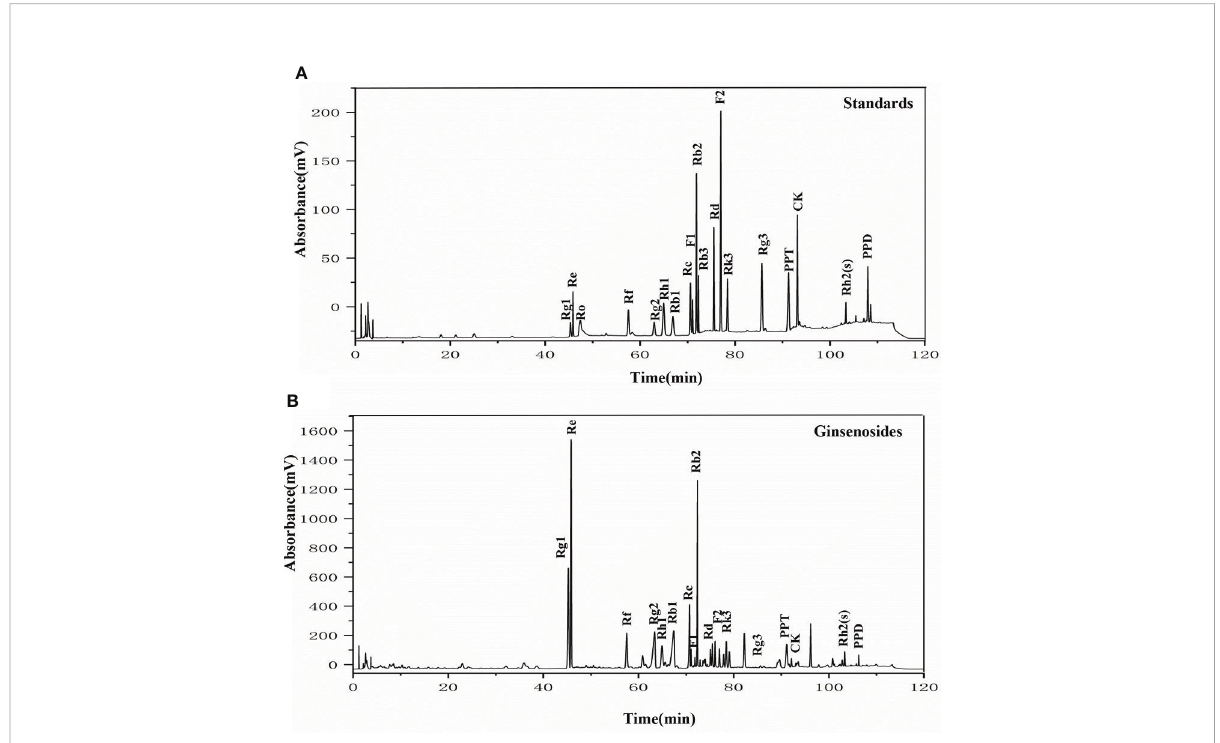
FIGURE 5 The HPLC chromatogram of ginsenosides. (A) HPLC analysis of the standard ginsenosides monomers including Rg1, Re, Ro, Rf, Rg2, Rh1, Rb1, Rc, F1, Rb2, Rb3, Rd, F2, Rk3, Rg3, PPT, CK, Rh2(s), and PPD; (B) HPLC chromatogram of ginsenosides test samples, with UV detection at 203